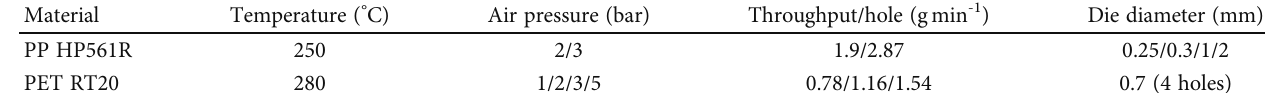
Table 2: Process parameters utilised during melt